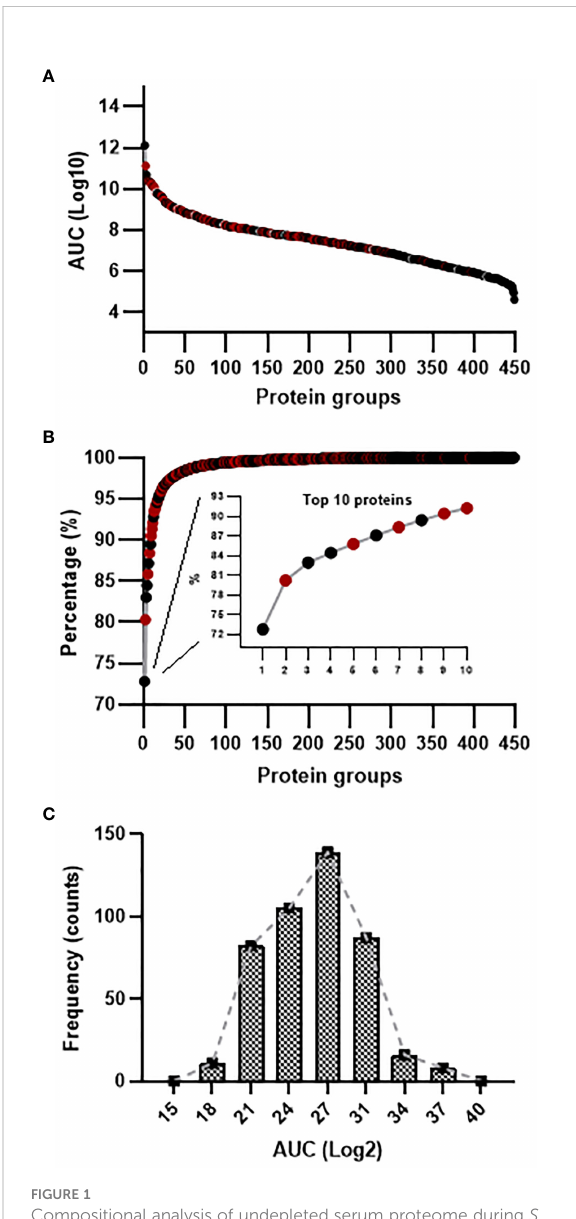
FIGURE 1 Compositional analysis of undepleted serum proteome during S. mansoni infection in the BALB/c mice. (A) Dynamic range of identi fi ed proteins encompassed fi ve orders of magnitude difference between the most and least abundant serum constituent, as judged by Area Under Curve (AUC). (B) Cumulative abundance plot revealed 10 molecules contributing to 91% of the total ion signal. (C) Frequency histogram for protein abundance in the